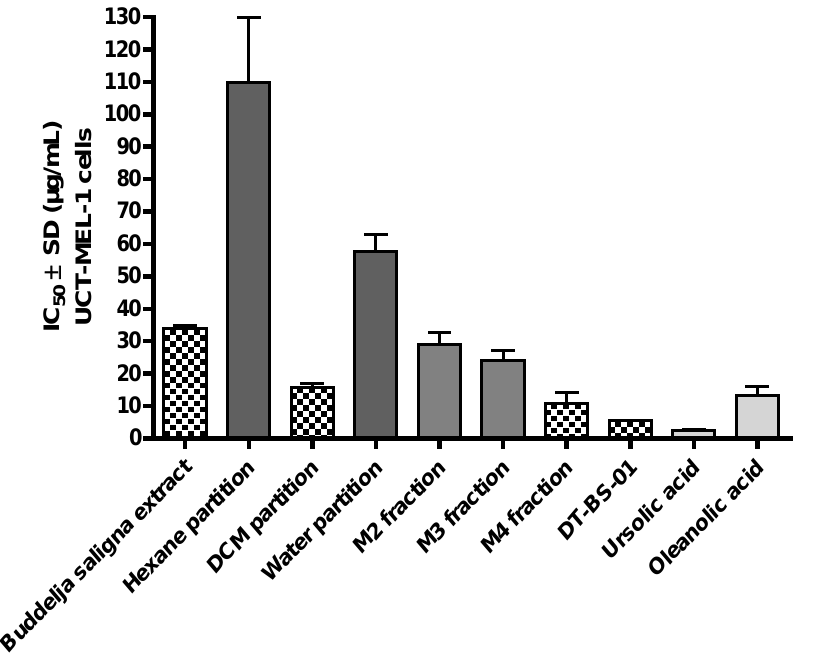
Figure 1. Chemical structures of ( a ) ursolic acid and ( b ) oleanolic acid. The antiproliferative activity of OA and UA was evaluated against UCT − MEL − 1 and HaCat cells, with UA exhibiting an IC 50 value of 2.31 ± 0.54 µg/mL (5.06 µM) and 2.32 ± 0.52 µg/mL (5.10 µM), cells treated with 5 µ g/mL DT-BS-01 (IC 50 on UCT-MEL-1) exhibited no signs of cell death, respectively (SI: 1.01), and OA showed an IC 50 value of 13.08 ± 3.03 µg/mL (28.64 µM) and 16.84 ± while UCT-MEL-1 cells exhibited apoptosis (condensed chromatin, apoptotic bodies and 1.32 µg/mL (36.87 µM), respectively (SI: 1.29). These findings showed that DT − BS − 01 has a higher selectivity towards UCT − MEL − 1 cells compared to non-tumorigenic keratinocytes. Moreover, membrane blebbing). At 20 µ g/mL DT-BS-01 (IC 50 on HaCat), UCT-MEL-1 cells exhibited a complete loss of cell structures and apoptosis, comparable to what was observed in HaCat cells; however, the cytoplasm was not as reduced.